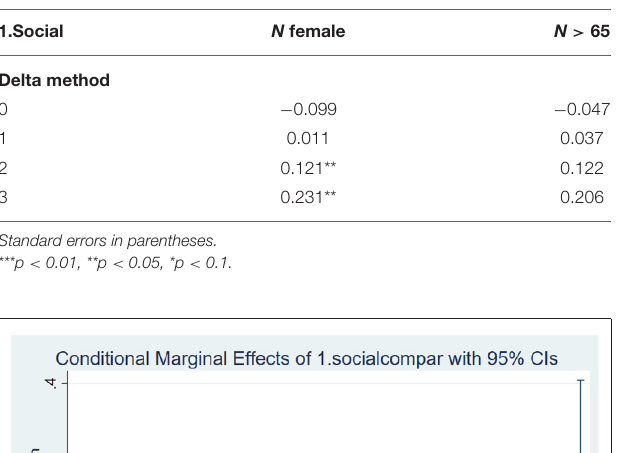
FIGURE 7 | Conditional marginal effects of